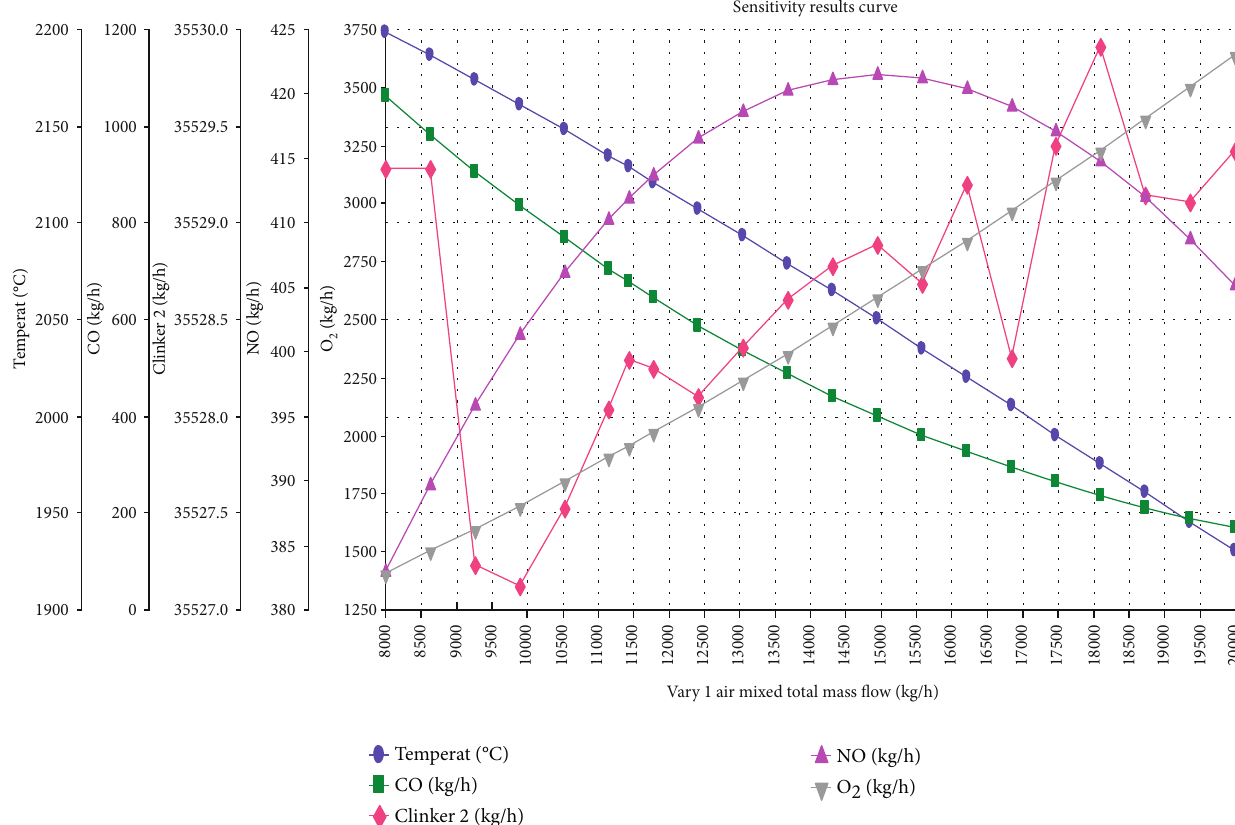
Figure 6: Primary air fl ow rate (horizontal axis) vs. clinker production, O